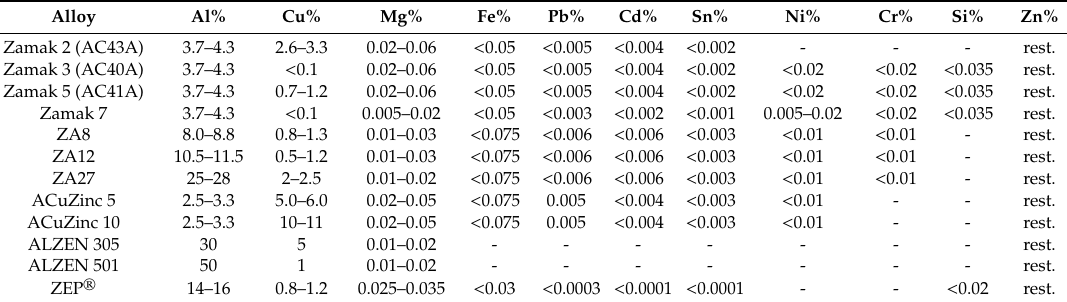
Table 1. Chemical composition (wt. %) of some zinc-base alloys [13].